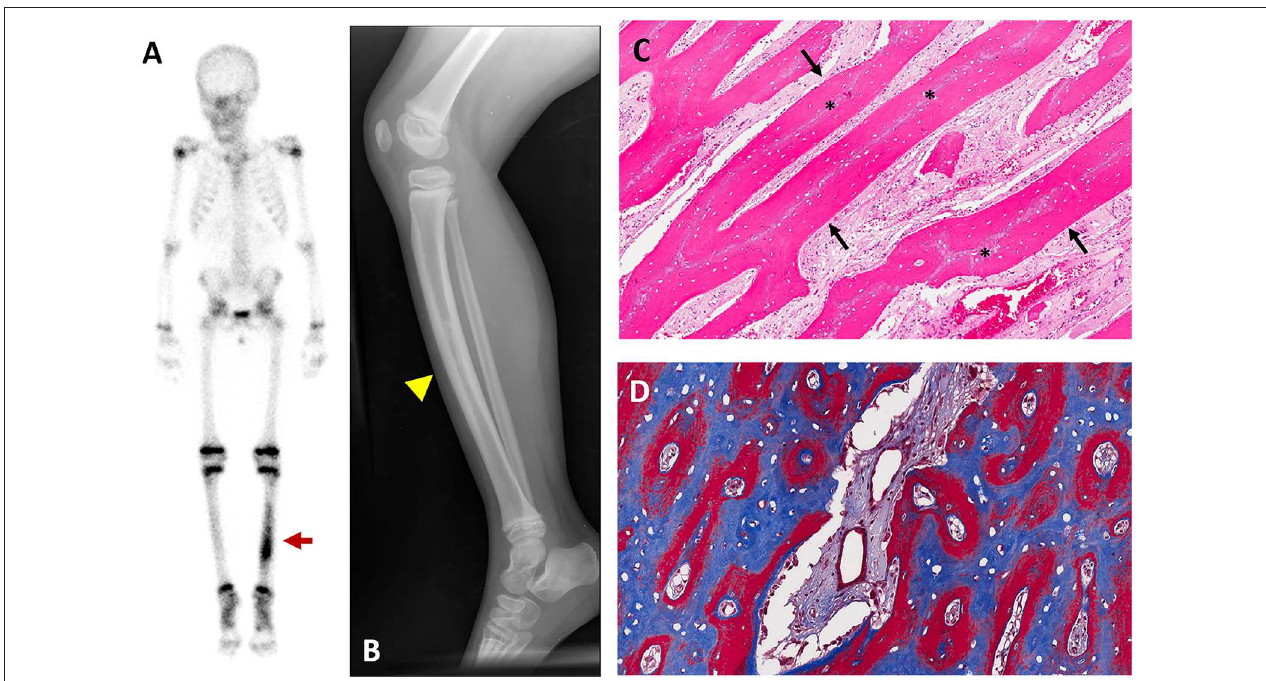
FIGURE 2 | Representative images of hyperostosis. Images are from a 4-year-old girl who presented with pain and tenderness over her tibia. (A) Technetium-99 bone scintigraphy shows increased uptake in the bilateral tibias, greater on the left (red arrow). (B) Radiograph of the left tibia shows thickened cortices with patchy radio-opacities in the medullary canal (yellow arrowhead). (C) Hematoxylin and Eosin stained section of periosteal bone from a tibial biopsy shows sheets of mineralized lamellar bone (arrows) replacing central areas of woven bone (asterisks). (D) Goldner trichrome staining in an undecalcified section reveals mature lamellar bone in blue and woven bone in red. These figures are original, and have not been previously published or obtained from a private database. There is no unpublished data in any of the